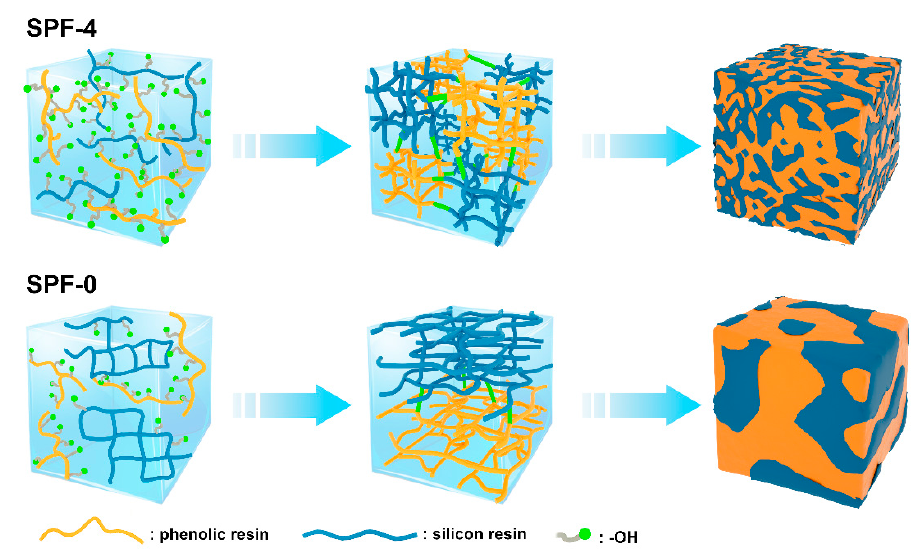
Figure 12. Schematic of the phase separation mechanism of SPF resins during curing.